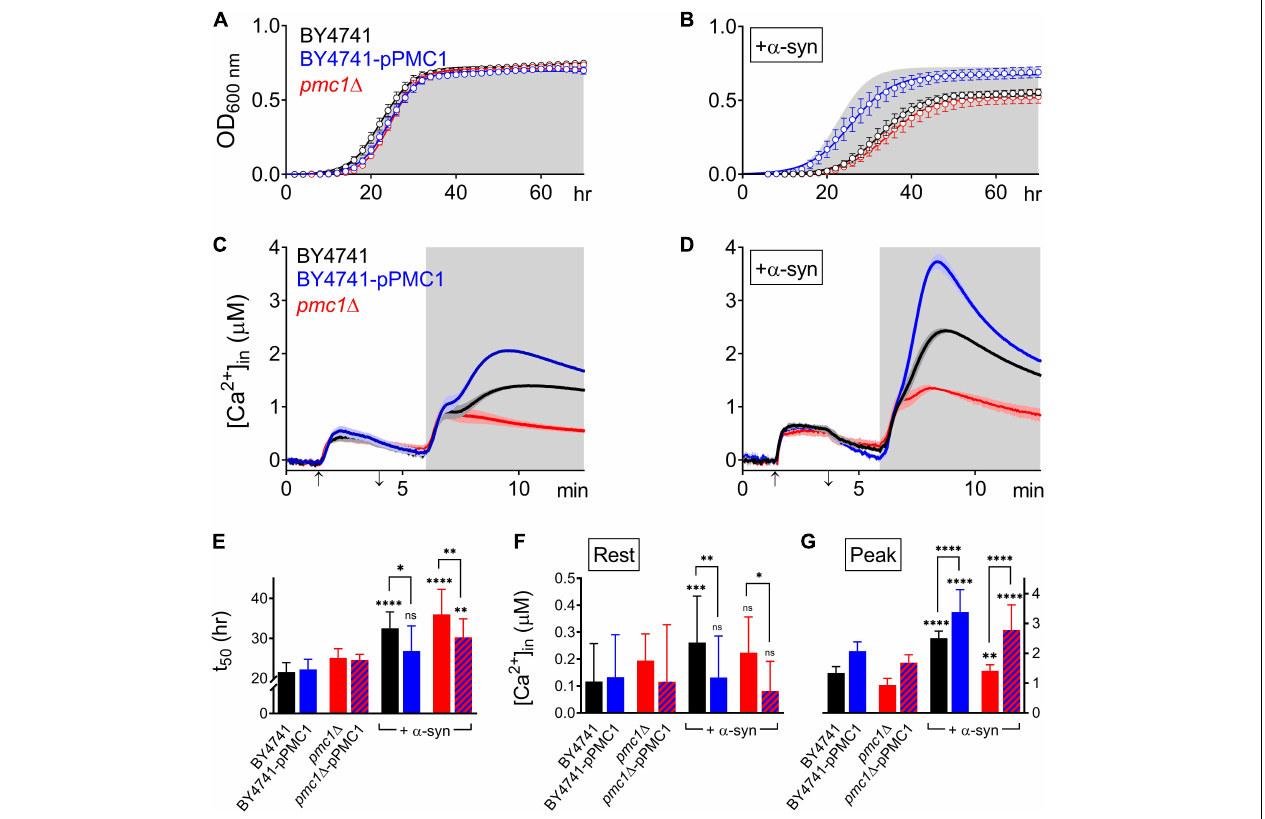
FIGURE 5 | α -Syn overexpression in PMC1 mutant strains. (A,B) Cell growth analysis of BY4741 yeast strains. OD 600 measurements were obtained for BY4741 cells (black), cells overexpressing PMC1 (BY4741-pPMC1 – blue) and pmc1 (cid:49) cells (red) without (A) or with overexpression of α -syn (B) . Gray shaded area in (B) corresponds to growth curve of control BY4741 cells (A) . Each time point represents the average ± SEM of triplicate cultures. (C,D) Averaged Ca 2 + transient ± SEM (thin lines either side of the Ca 2 + transient trajectory) of BY4741 cells (black), cells overexpressing PMC1 (BY4741-pPMC1 - blue) and pmc1 (cid:49) cells (red) without (C) or with overexpression of α -syn (D) at 30 ◦ C. Cells were initially perfused with Ca 2 + -free starvation medium and then transferred to a 10 mM external Ca 2 + medium for 2 min (indicated by up and down arrow on X -axis). Thereafter, cells were briefly exposed to Ca 2 + -free intracellular medium prior to membrane permeabilization using Triton X-100 (indicated by light gray zone). (E–G) Comparison of t 50 (time to reach half-maximal OD 600 ) (C) , Rest [Ca 2 + ] ([Ca 2 + ] in value determined at the end of the Ca 2 + -free period prior to permeabilization) (D) and Peak [Ca 2 + ] (peak amplitude of the Ca 2 + release transient following permeabilization) (E) for PMC1 mutant strains without and with α -syn overexpression. Bar graphs depicting mean ± SD. The statistical significance was assessed using one-way ANOVA with Bonferroni posttest. Unless otherwise indicated by connecting bar, differences were tested with respect to the control strain (without α -syn expression). ns (not significant) P > 0.05; * P ≤ 0.05; ** P ≤ 0.01; *** P ≤ 0.001; **** P < 0.0001. Mean and P -values are listed in Tables 4 , 5